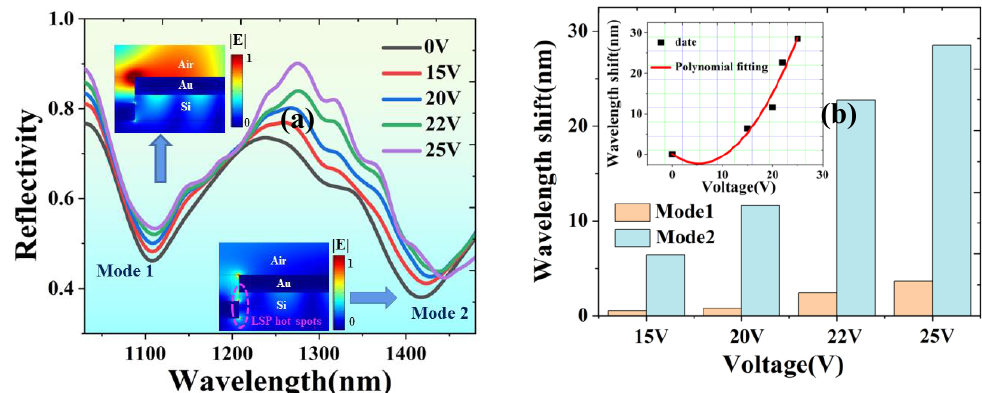
Figure 9. ( a ) Electrically tunable Fano resonance spectrum. Inset: local amplification of electric field distribution of Mode 1 and Mode 2. ( b ) Comparison of resonant wavelength shift between Mode 1 and Mode 2. Inset: Polynomialfitting of wavelength shift of Mode 2.